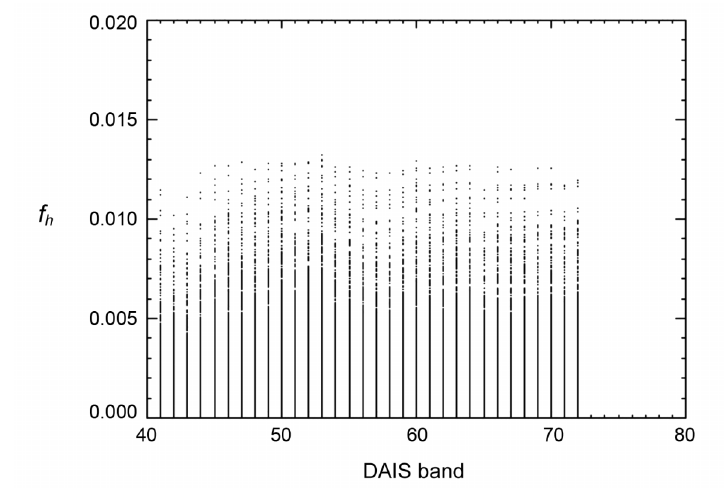
Fig. 2. f h solutions calculated for each pixel as a function of the DAIS band number.